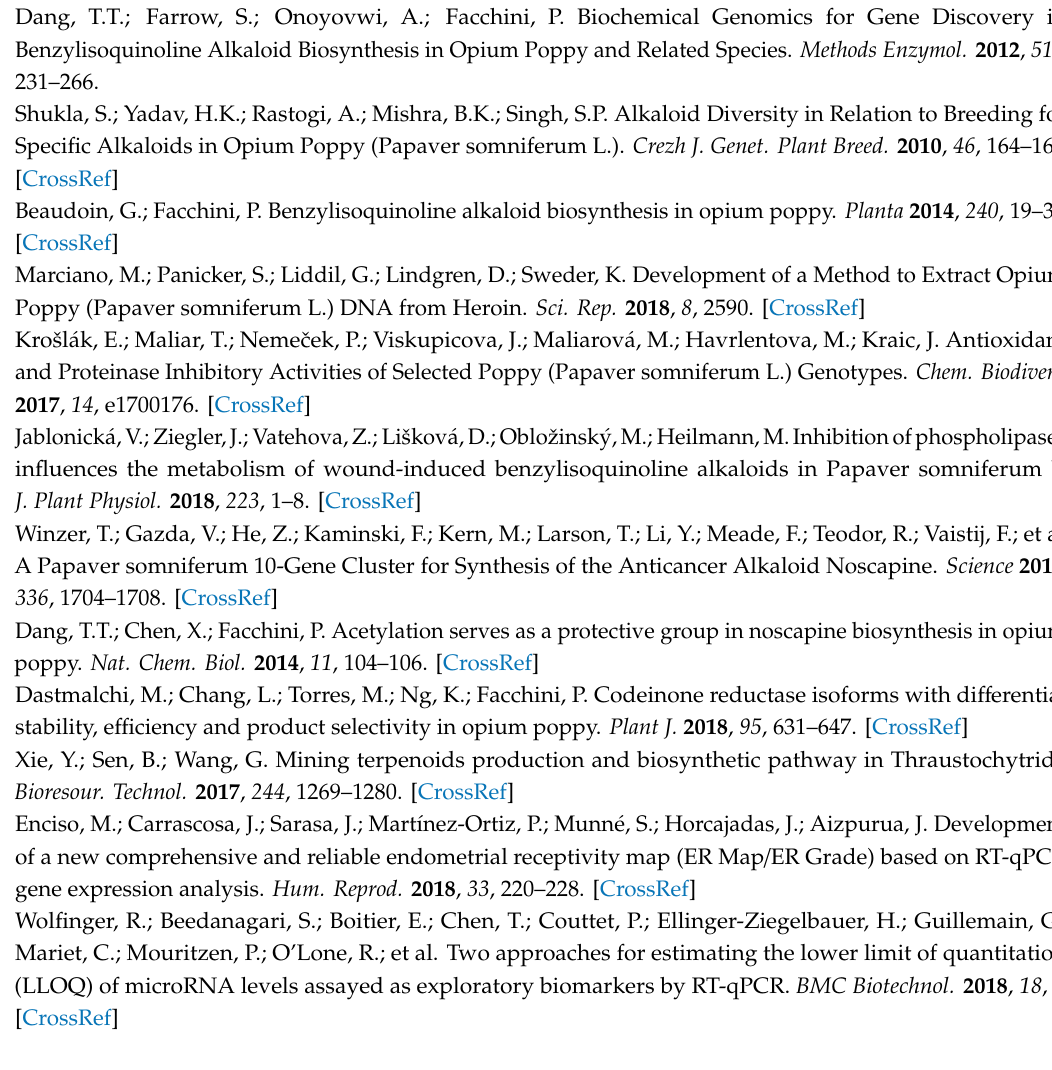
Table S1: The sequences used for primer design. Table S2: The PCR products sequencing data of nine reference genes. Table S3: Pairwise variation (Vn / n + 1) analysis of nine candidate reference genes calculated by geNorm. Table S4: Expression stability values of nine candidate genes calculated by RefFinder in P. somniferum . Table S5: Rankings of nine candidate reference genes based on stability values calculated by four kinds of software. Figure S1: The agarose gel electrophoresis of PCR products using nine reference genes. Figure S2: Melting curves of the nine candidate reference